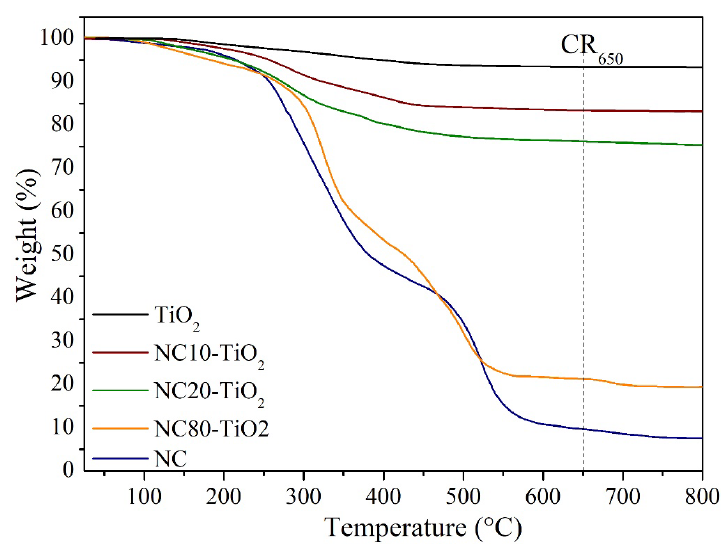
Figure 2. TGA of ( – ) TiO 2 , ( – ) NC, ( – ) NC10-TiO 2 , ( – ) NC20-TiO 2 , and ( – ) NC80-TiO 2 .